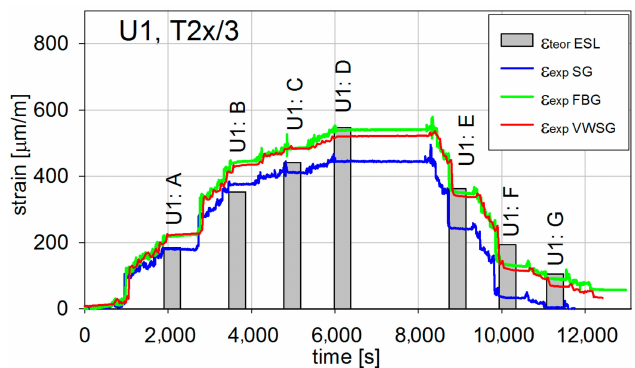
Figure 15. Longitudinal strains in T2x / 3 for the U1 test.